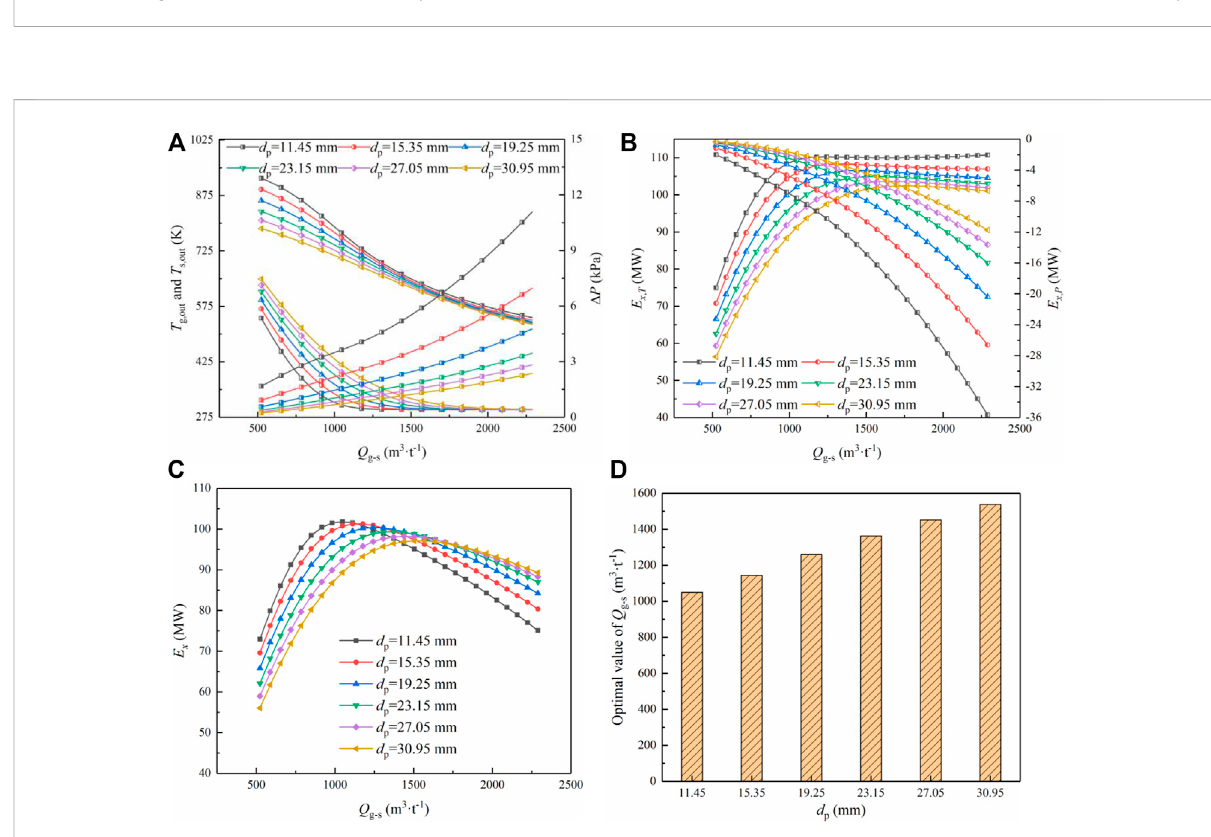
FIGURE 13 Thein fl uenceofthe fl owrateratioofgastosinter Q g − s ontheverticalcoolingprocessunderdifferentmulti-sizesinters: (A) Changeofthesinter outlet temperature T s , out , gas outlet temperature T g , out and pressure drop Δ P with Q g − s ; (B) Change of the temperature exergy E x , T , and pressure exergy E x , P with Q g − s ; (C) Changeoftheincomeexergy E x with Q g − s ; (D) Changeoftheoptimalvalueof Q g − s withtheequivalentparticlediameter d p